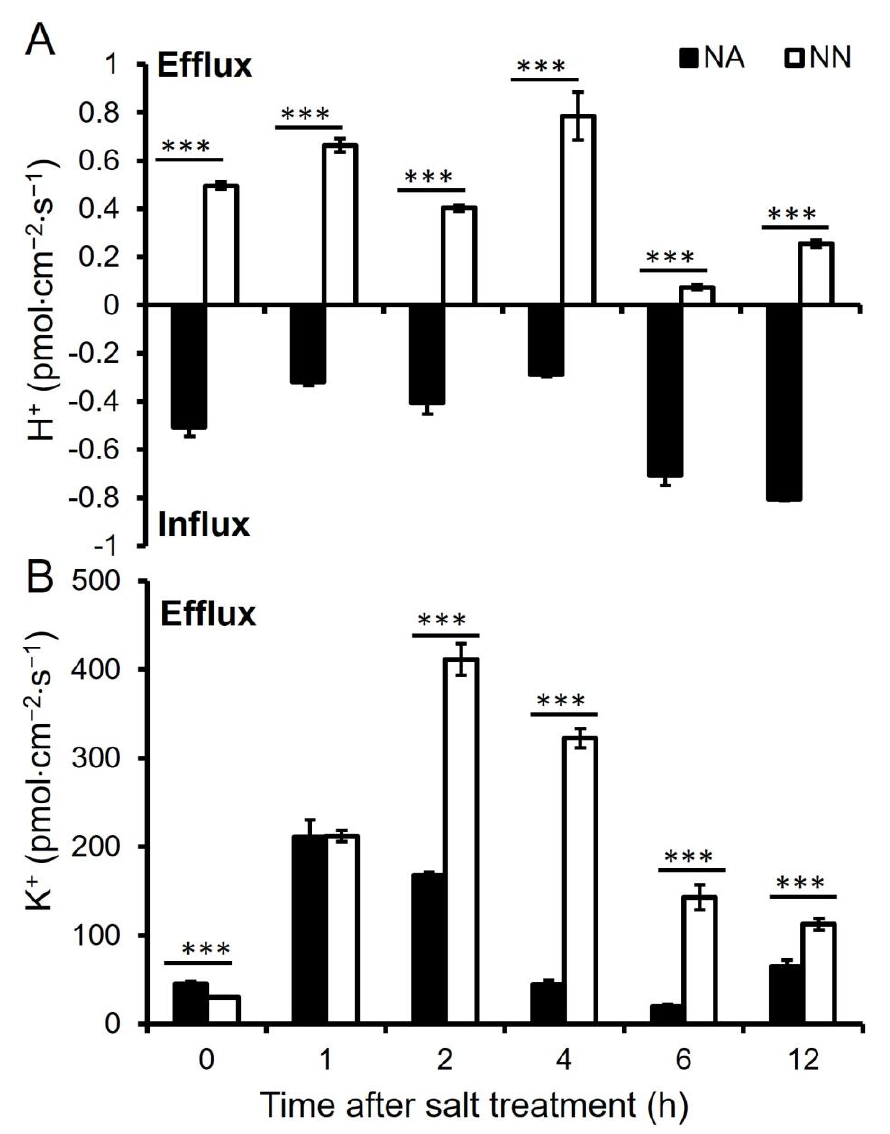
Figure 4. The net H + ( A ) and K + ( B ) flux under different periods of salt stress of alfalfa root tip. The positive and negative values indicate external and internal ion flux, respectively. NA: alfalfa plants with active nodules; NN: alfalfa plants without nodules. Data are shown as means ± SE ( n = 8). *** indicates a significant difference between NA and NN roots at p < 0.001.